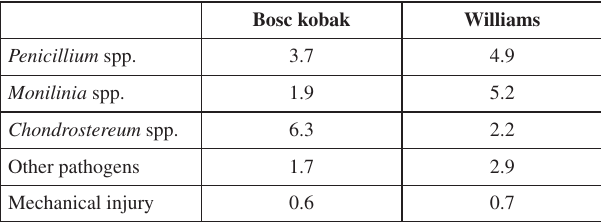
Table 4. Types of postharvest damage on two pear cultivar uner traditional cold storage condition (Nagykanitsa,